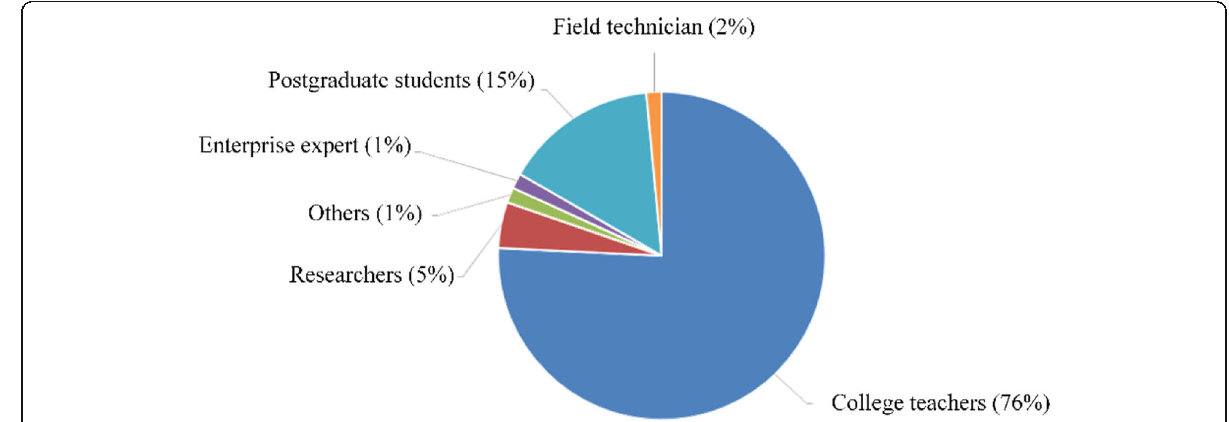
Fig. 4 Proportion distribution of the